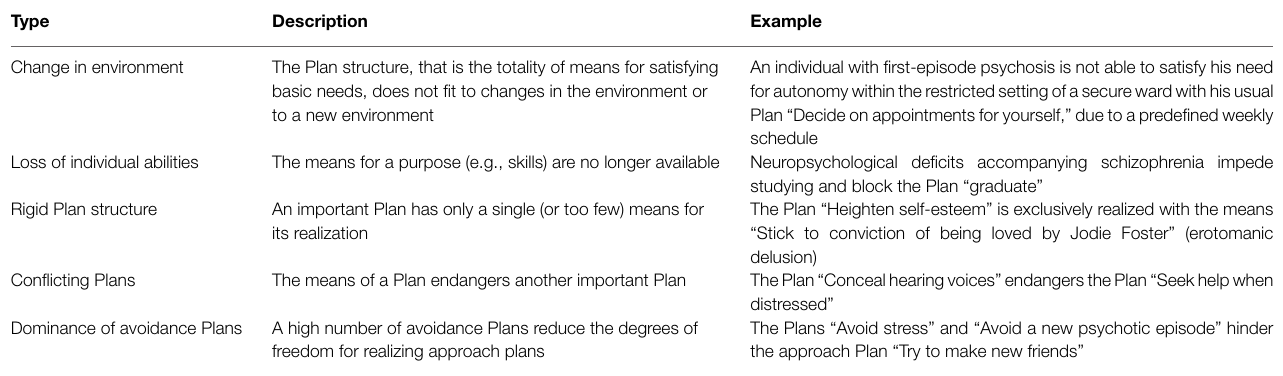
TABLE 1 | Sources of negative emotions from a Plan Analysis